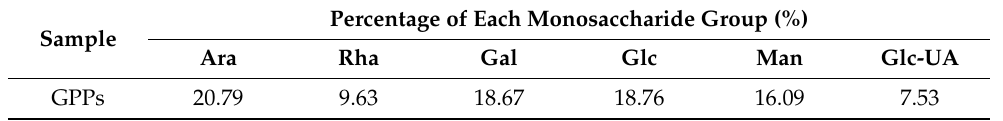
Table 4. Monosaccharide composition of grape pomace polysaccharides.